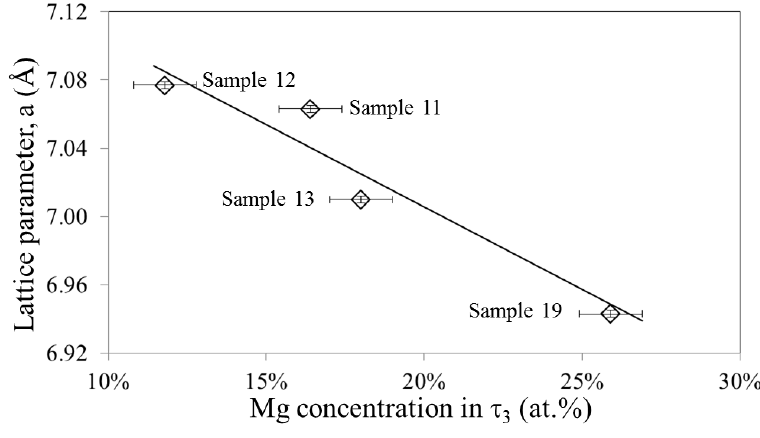
Figure 17. Variation of lattice parameter of τ 3